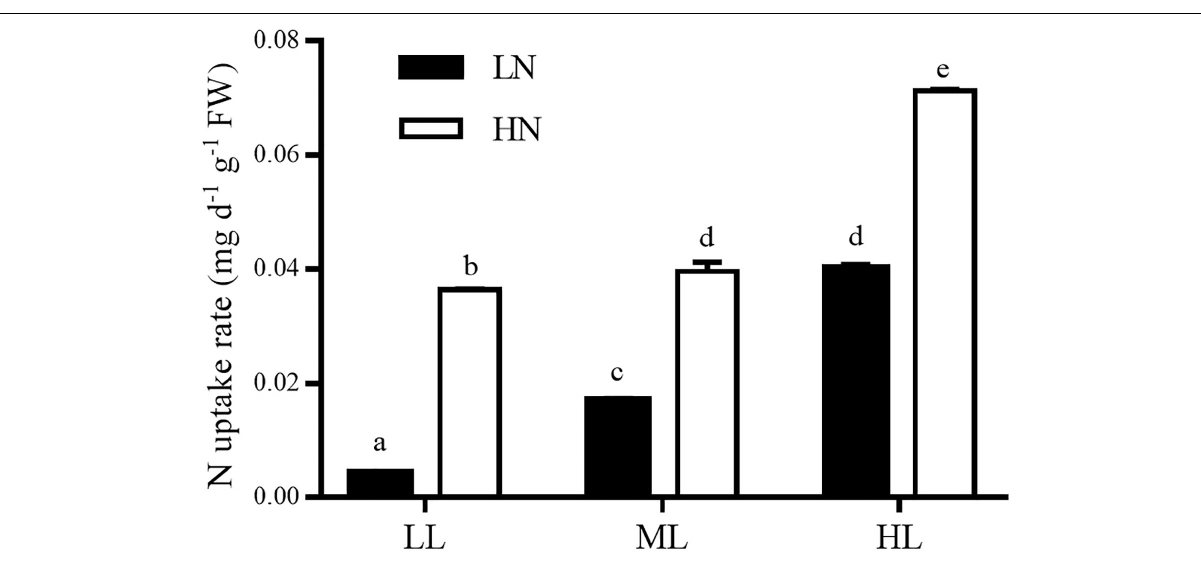
FIGURE 6 | Nitrogen uptake rates of S. muticum grown at different light and nitrogen levels, which were determined during 2 days at the end of 12 days of incubation. Significant ( P < 0.05) differences among the treatments are indicated by different lowercase letters. Vertical bars represent ± SD for the means of three